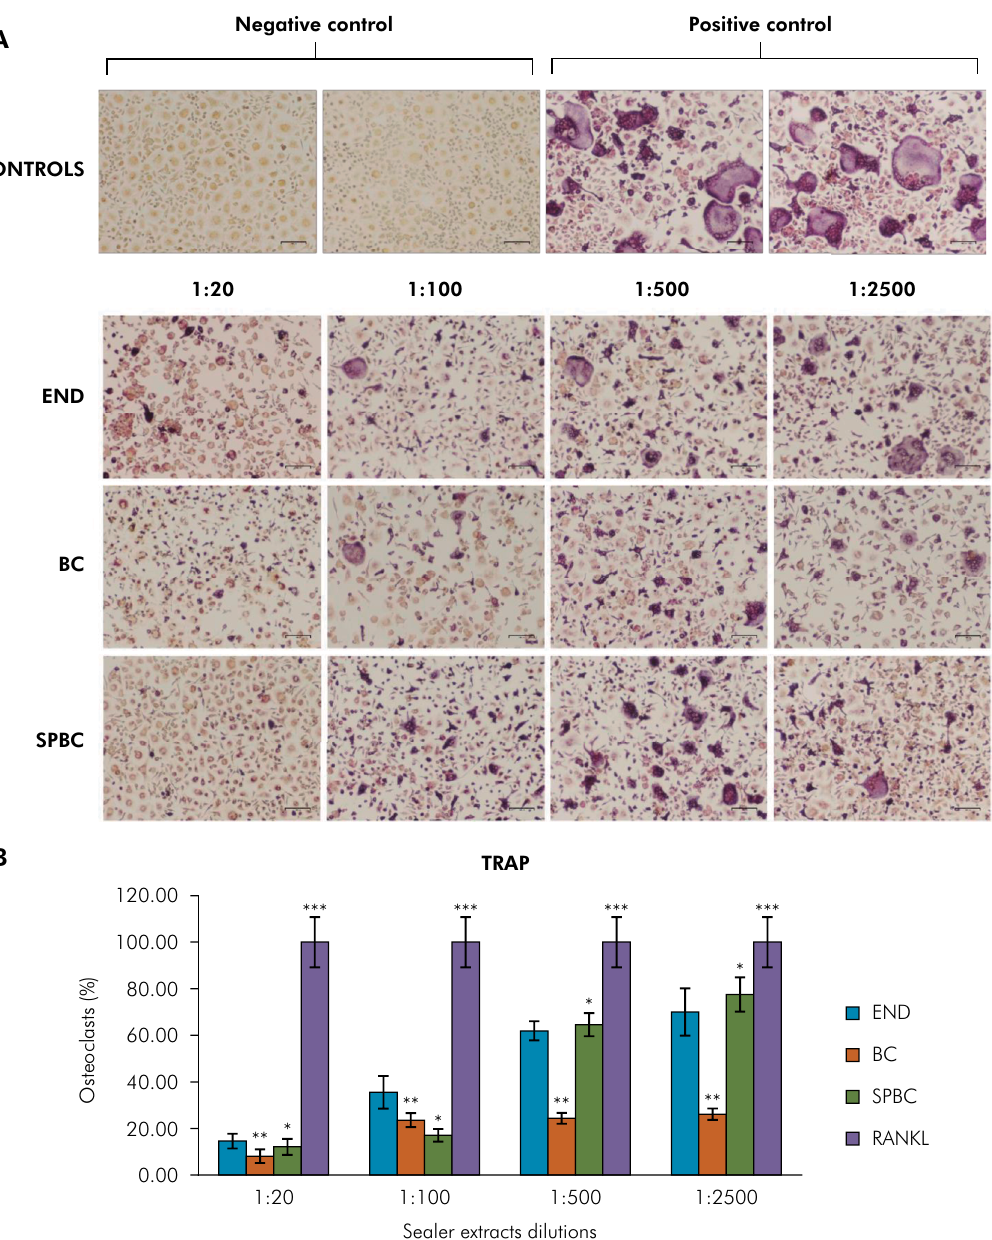
Figure 4. TRAP stain. (A) Osteoclastic differentiation by TRAP-positive multinucleated cells compared with the positive control (RANKL) and the negative control groups ( α -MEM);